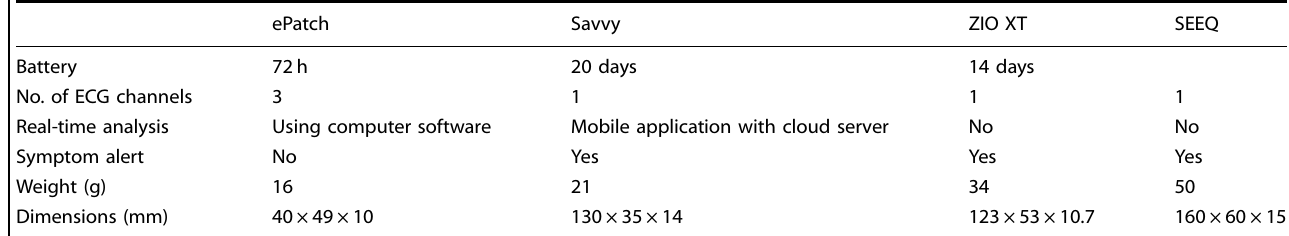
Table 2. Commercially available ECG